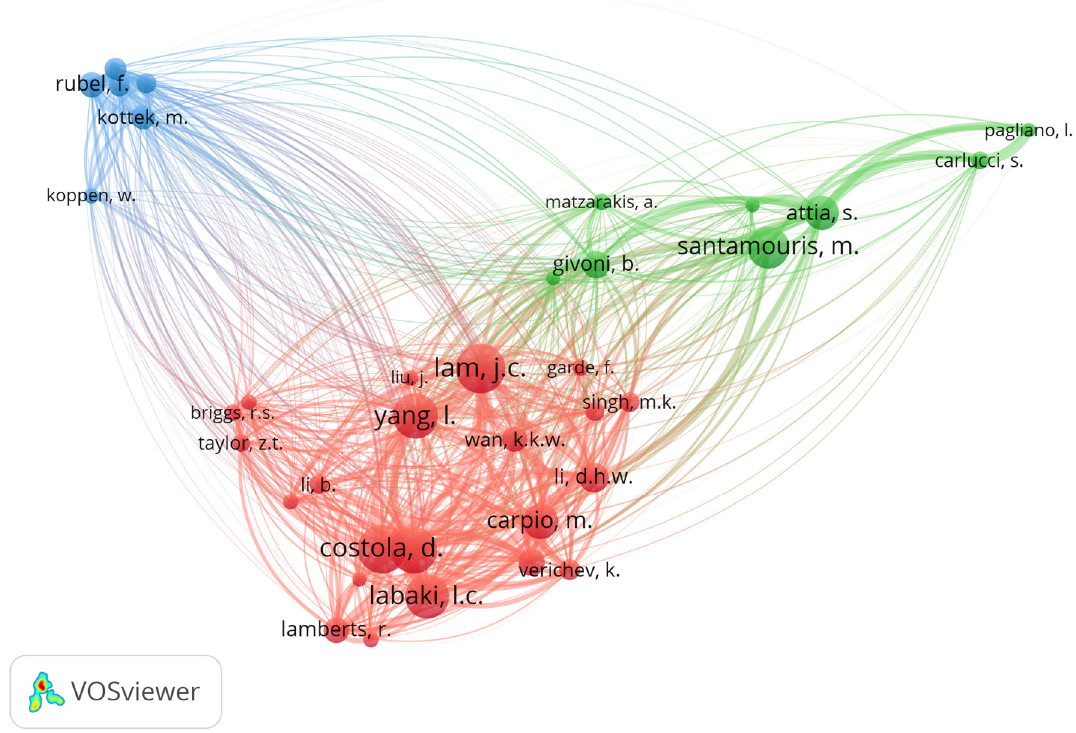
Figure 17. Co-citation network of researchers.